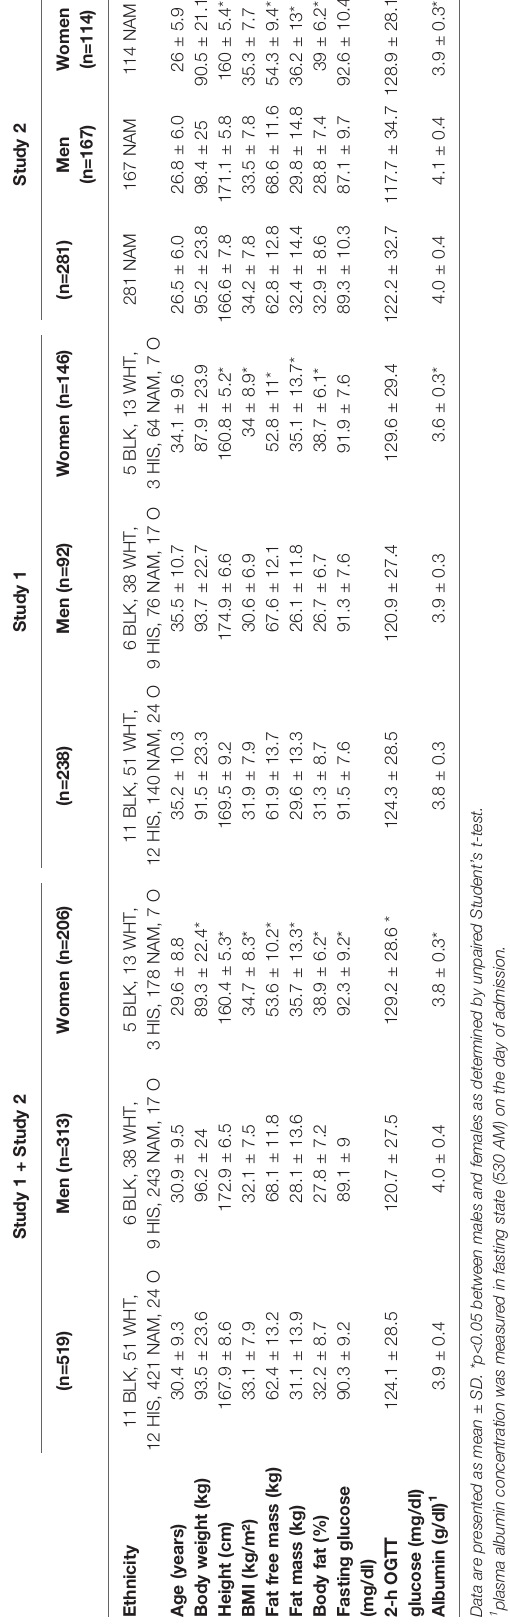
Figure 2A ), re fl ecting higher carbohydrate ( b = 44.0 kcal/day, p=0.0078, Figure 2B ), fat ( b = 33.8 kcal/day, p=0.023, Figure 2C ) and protein ( b = 13.8 kcal/day, p=0.001, Figure 2D ) intake after adjustment for their known determinants (age, sex, ethnicity, FMI, and FFMI). Also, lower albumin correlated with higher % WMEN (r=-0.2, p=0.002) after adjustment for age and sex. We did not observe any difference between plasma albumin and total daily energy intake (adjusted for age, sex, FMI, and FFMI) in the fi ve different ethnic groups (albumin × ethnicity interaction term